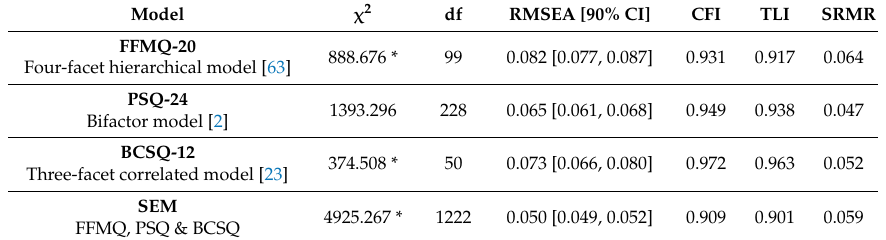
Table 3. Fit statistics for latent structure models for Five Mindfulness Facets Questionnaire